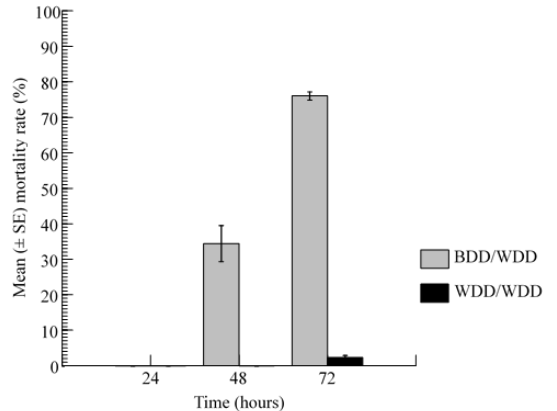
Figure 3. Mortality rates of the adult house flies when allowed to forage in an enclosure with a mixed pair of floral arrangements (one BDD delivering toxic sugar and one WDD with non-toxic sugar) and another enclosure with a pair of